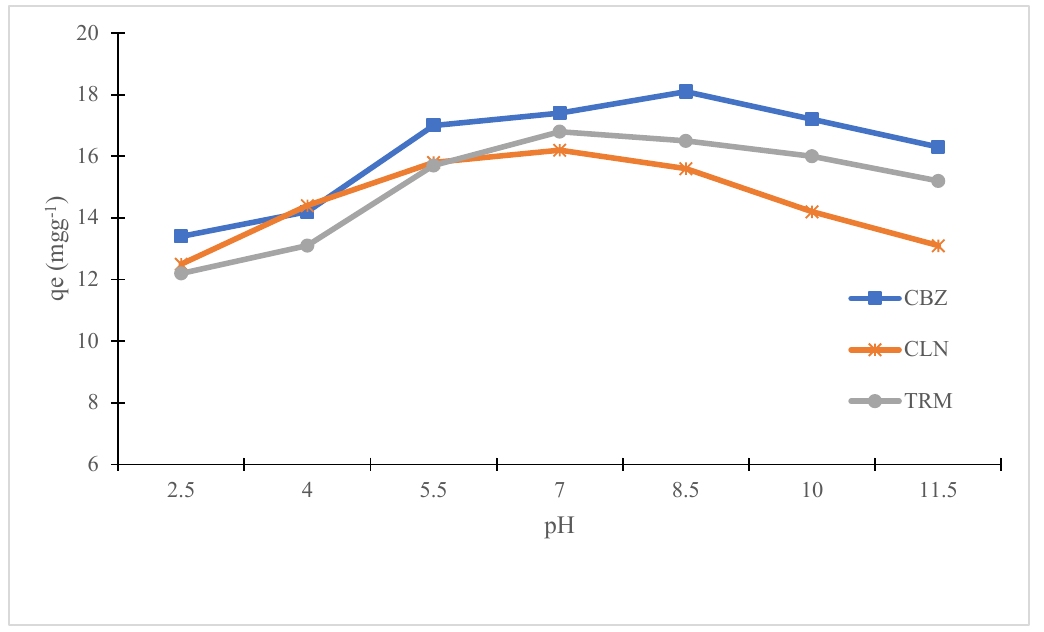
Figure 6. Effect of the pH on the API adsorption for CPAC. Table 5. Langmuir and Freundlich coefficients of adsorption isotherms and the correlation coefficients of the experimental data.